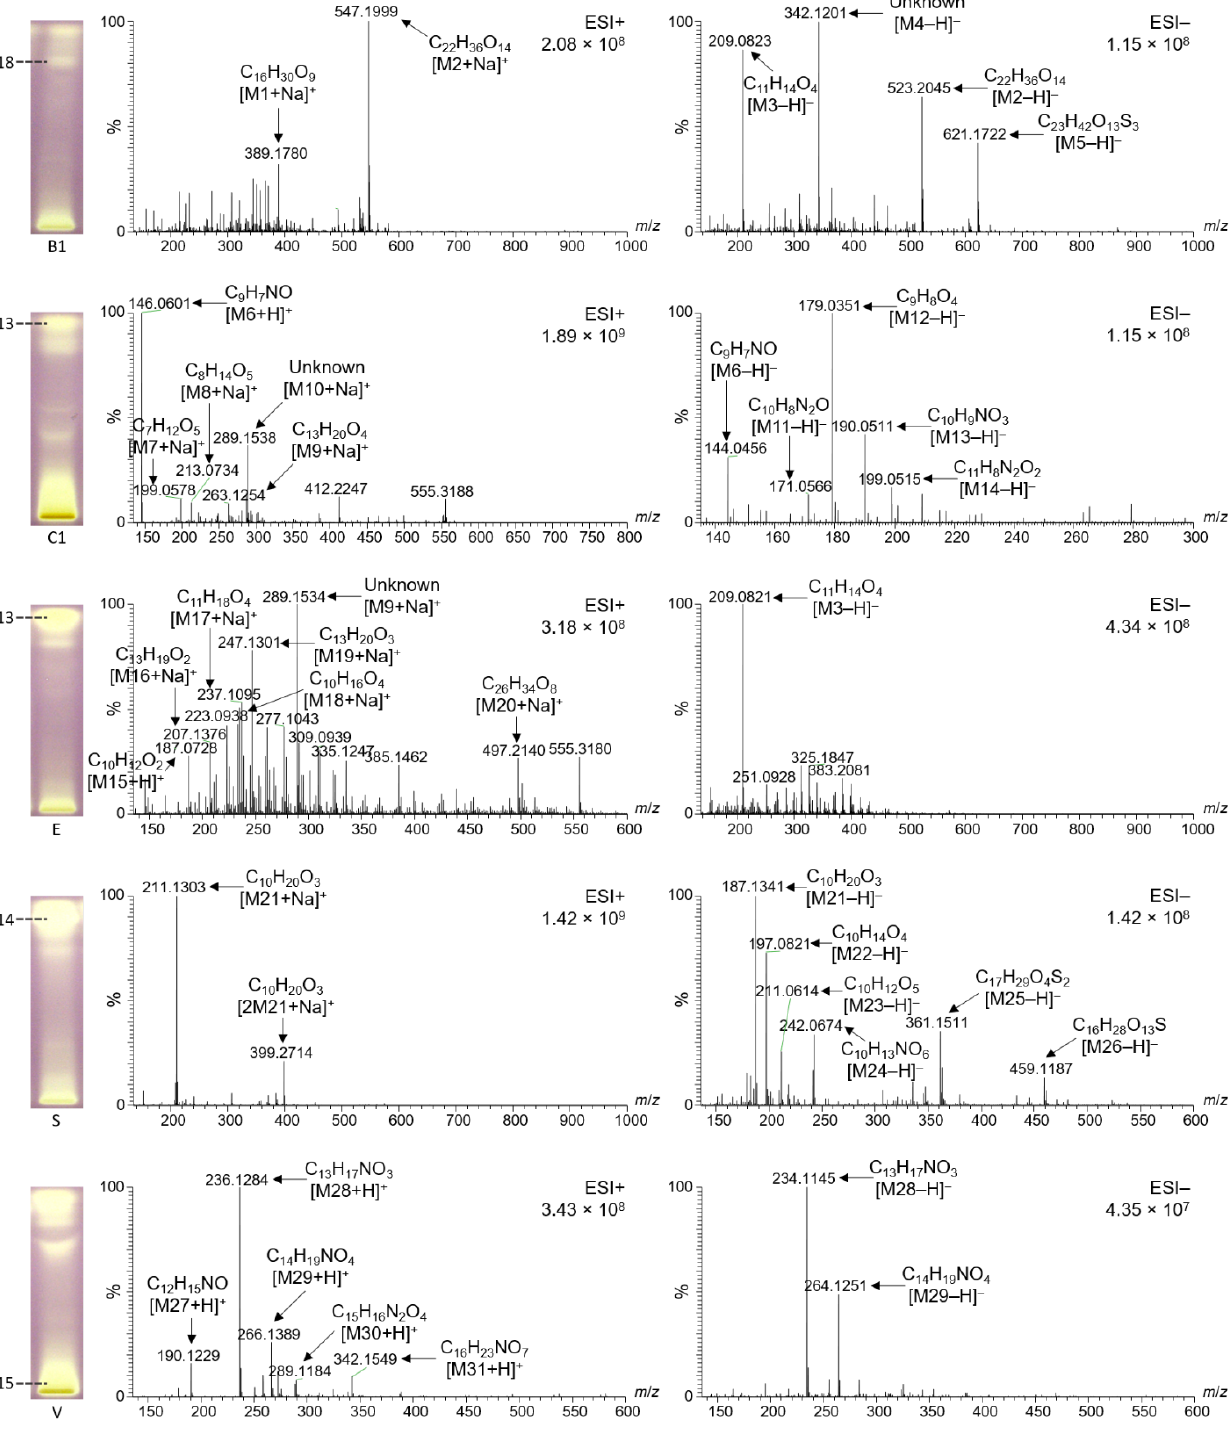
Figure 4. HPTLC–HESI–HRMS spectra in the positive and negative ionization mode of prominent bioactive zones detected via the DPPH• radical scavenging assay (for orientation, zones are marked as in Figure 2) of different monofloral honeys (IDs below the chromatogram stripe, assigned as in